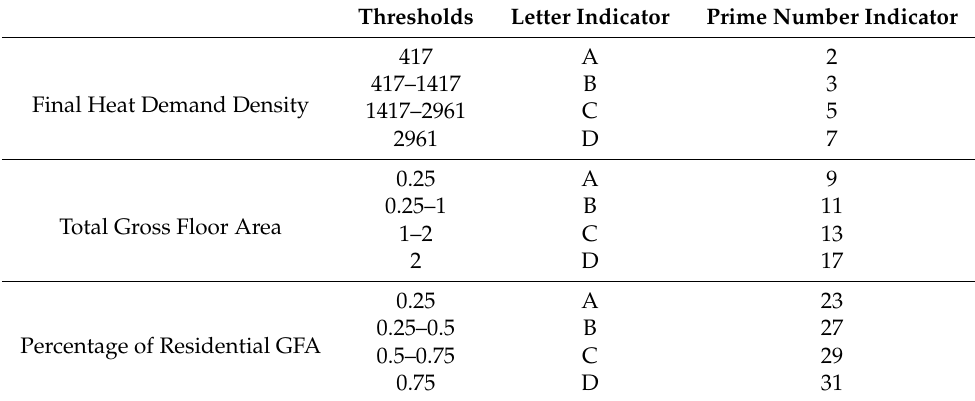
Table A2. The code to transform letter indicators into prime numbers and vice versa.